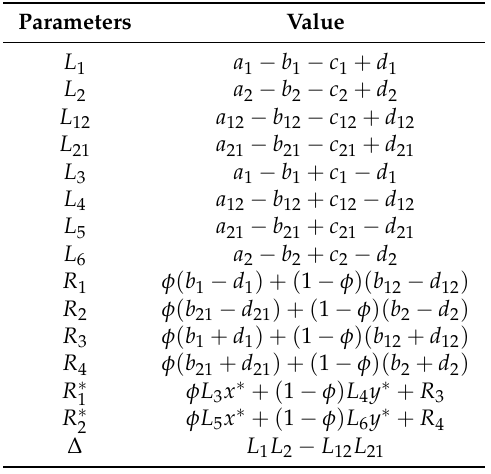
Table 1. This is a table caption. Tables should be placed in the main text near to the first time they are